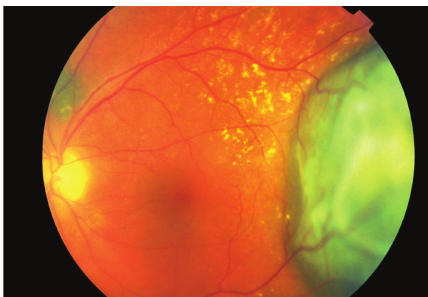
Figure 7: Fluorescein angiogram of a large amelanotic choroidal melanoma, notice the double circulation sign with visible leaking choroidal vessels at the